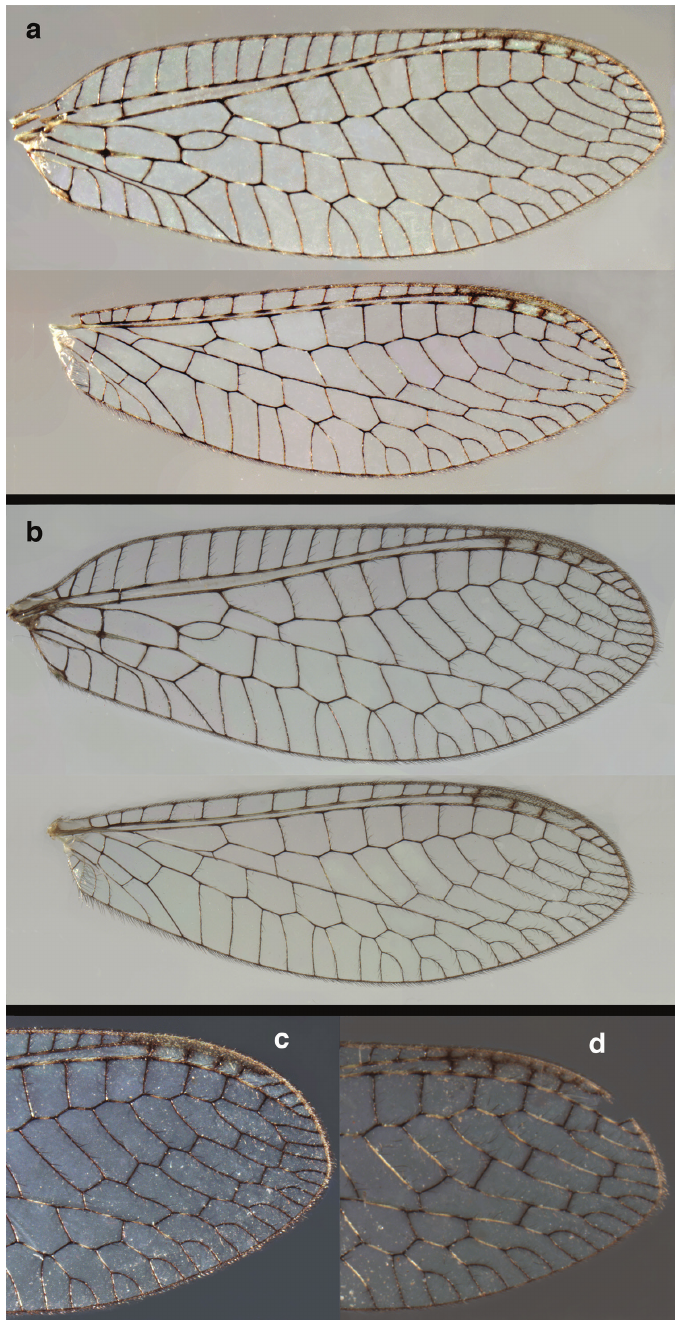
Figure 99. Ungla annulata Navás: Intra and interspecific variation in wings, ( a, b ) forewings (upper); hindwings (lower) ( c ) tip of forewing ( d ) for comparison, tip of forewing of U. argentina (Navás) (Argen- tina; a, b, c Salta, female, USNM; d Santiago del Estero, female,